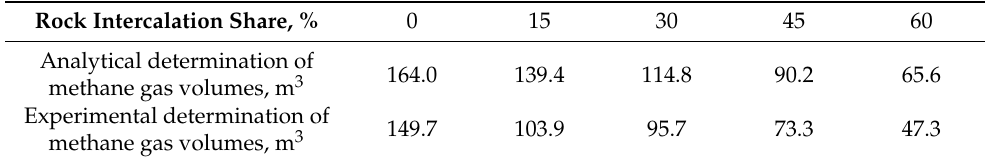
Table 1. Gas volumes obtained during the research on the dissociation process of 1 m 3 of gas hydrate deposits. Rock Intercalation Share,